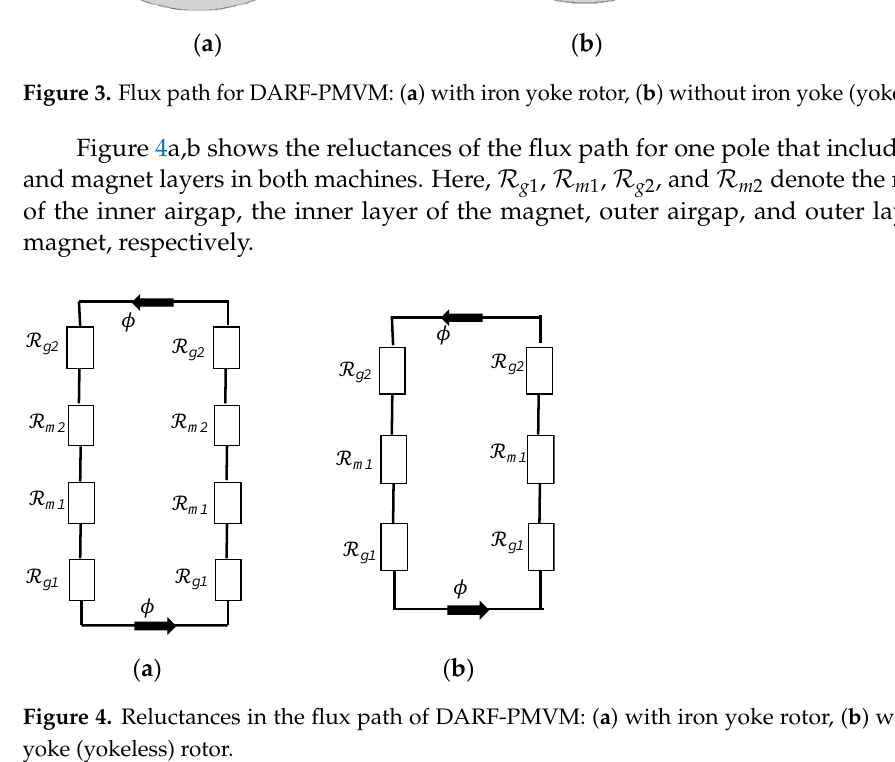
Figure 4. Reluctances in the flux path of DARF-PMVM: ( a ) with iron yoke rotor, ( b ) without iron yoke (yokeless) rotor.